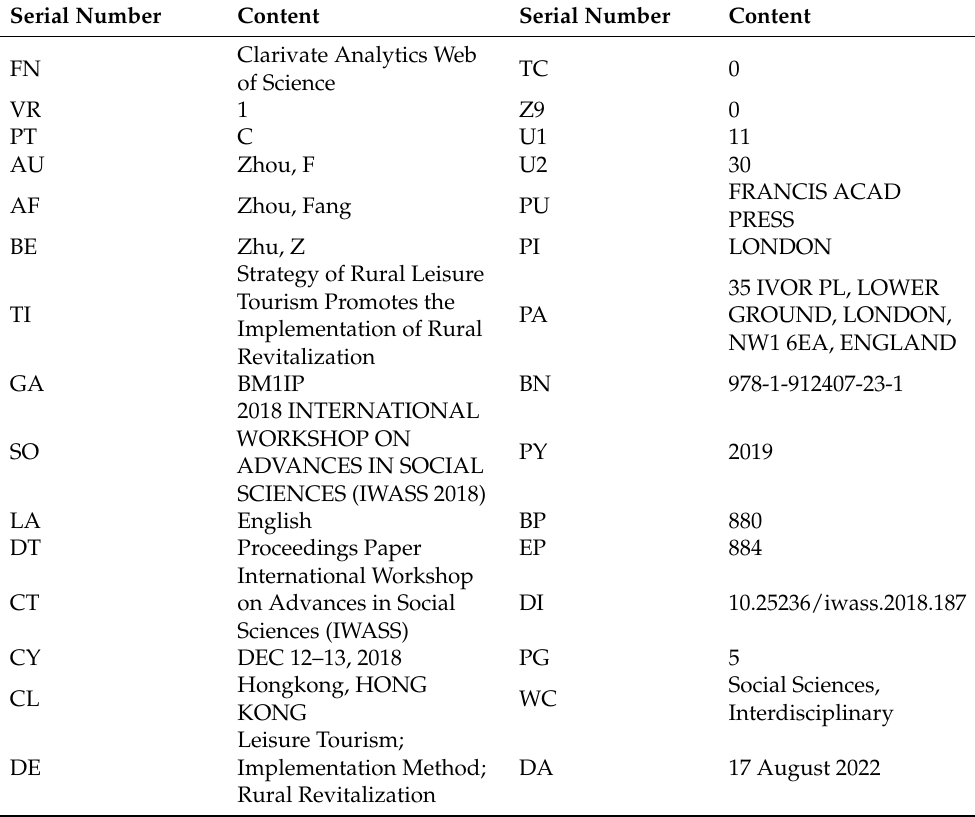
Table 1. Data document identifier and